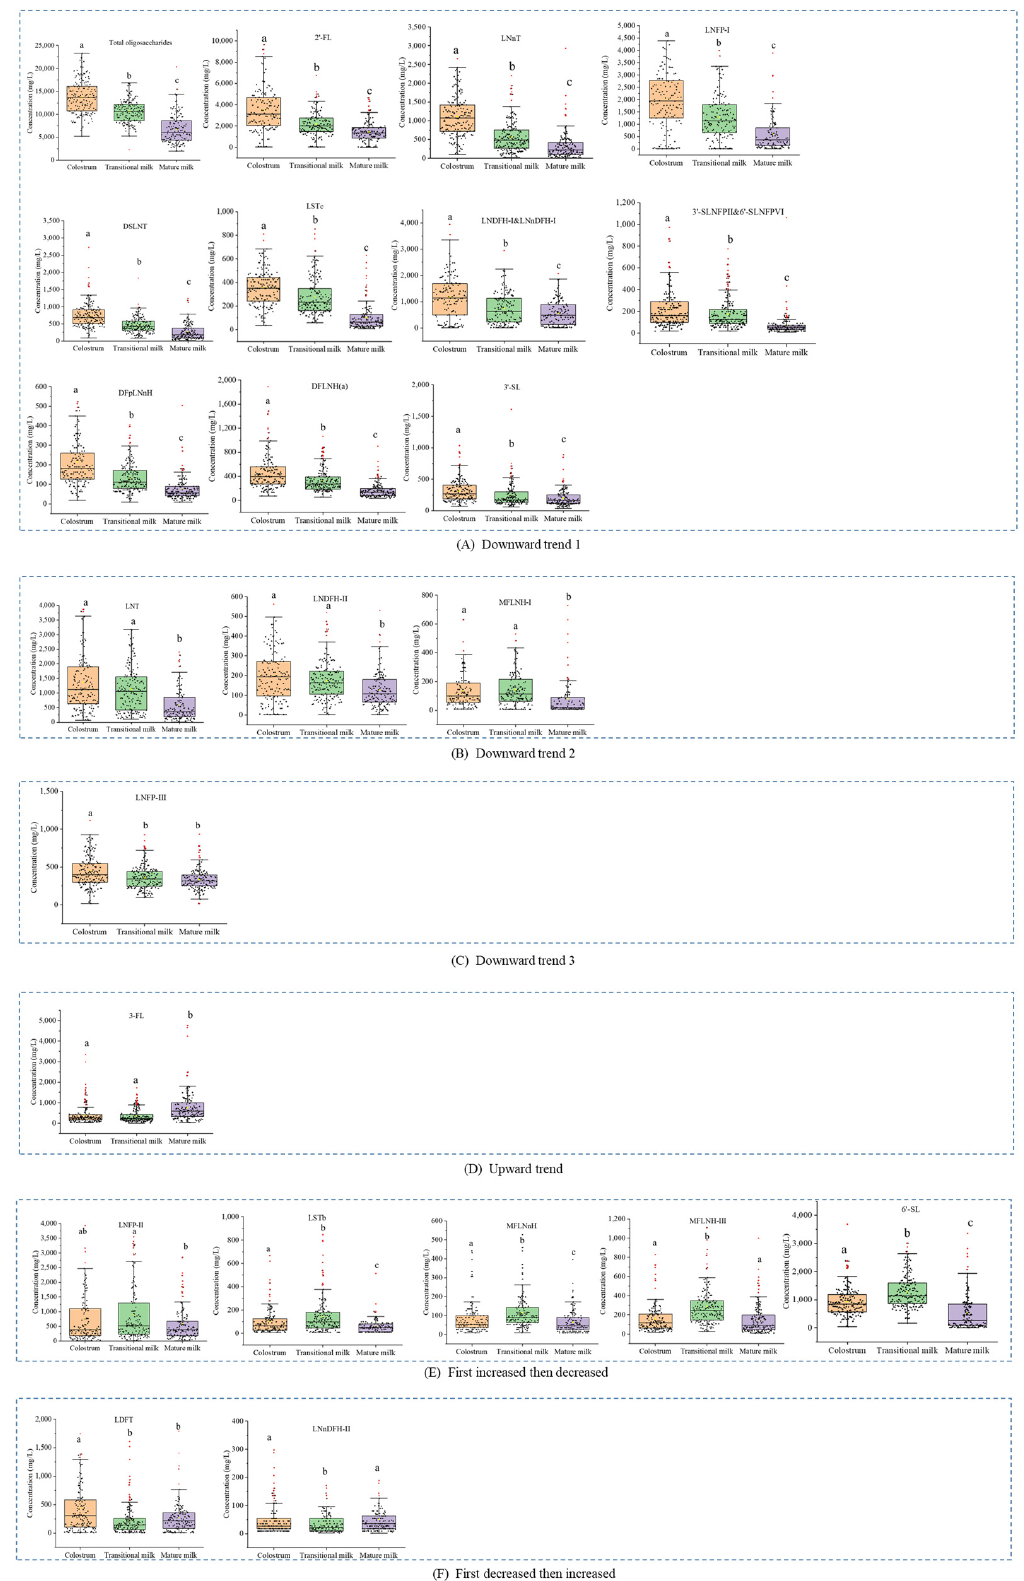
Figure 2. Box diagram of oligosaccharides in three lactation stages. Data are shown as median and quartiles. Different small letters indicate a significant difference ( p < 0.05). Brackets with numbers indicate the figure number.